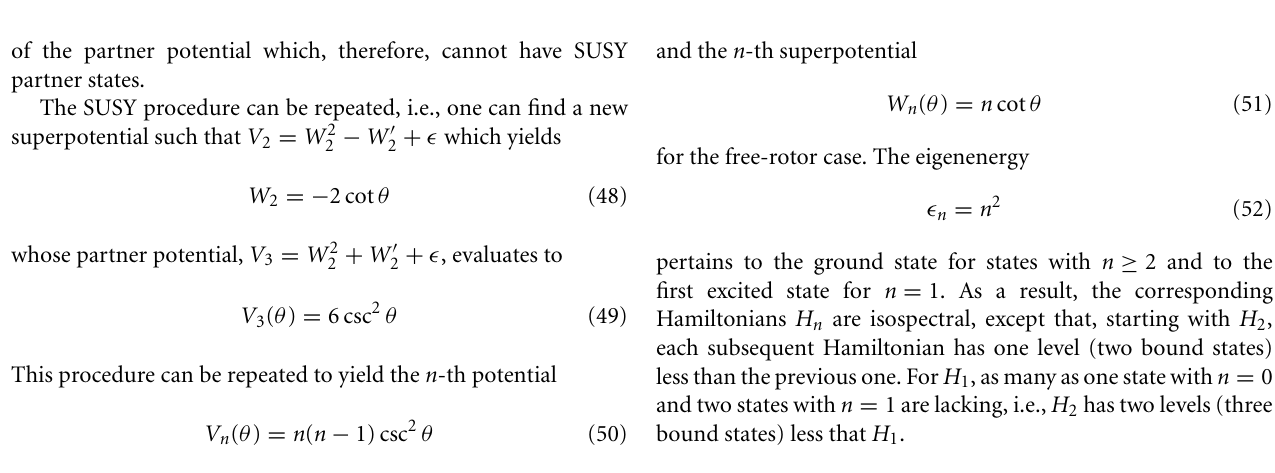
FIGURE 9 | Superpartner potentials V 1 (A) and V 2 (B), eigenenergies (dashed lines) and eigenfunctions (full curves) of Hamiltonian (Equation 1) with η = 15 ,ζ = 25 for a third-order intersection, κ = 3, see section